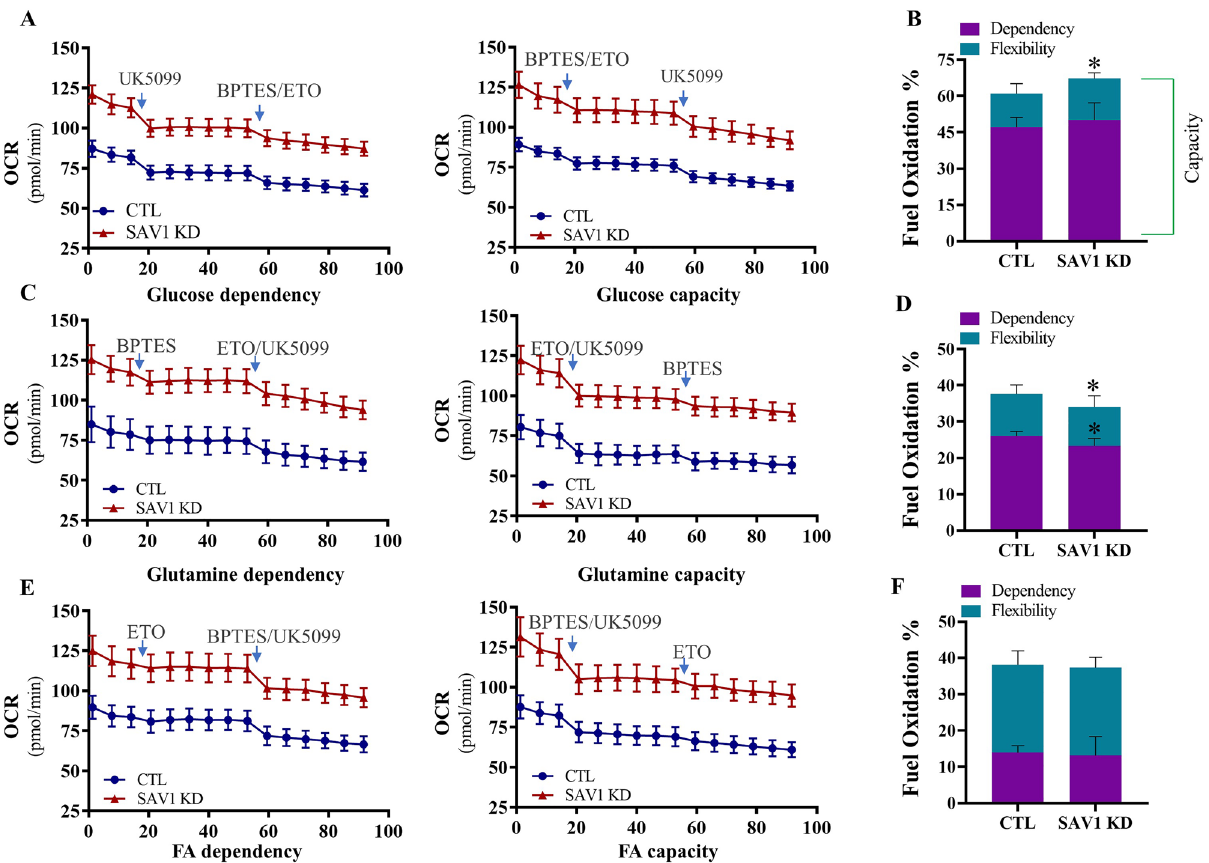
Figure 7. Distinct effects of SAV1 KD cells on mitochondrial flexibility for using fuel. ( A ) Representative traces of measurements of oxygen consumption rate (OCR) showing the dependency on and capacity for glucose oxidation after injection of inhibitors (individually or in combination) as indicated in the graph. UK5099: inhibits glucose oxidation; etomoxir (ETO): inhibits fatty acid oxidation (FAO); BPTES: inhibits glutamine oxidations. ( B ) SAV1 KD cells had significantly enhanced mitochondrial capacity to use glucose oxidation to compensate for inhibition of glutamine oxidation and FAO. Flexibility is the difference between capacity and dependency. *p < 0.05. ( C ) Representative traces of OCR measurements showing the dependency on and capacity for glutamine oxidation after injection of inhibitors (individually or in combination) as indicated in the graph. ( D ) SAV1 KD cells had a significantly lower dependency on and capacity in glutamine oxidation than CTL cells to compensate for the inhibition of glucose oxidation and FAO. *p < 0.05. ( E ) Representative traces of OCR measurements showing the dependency on and capacity for FAO after injection of inhibitors (individually or in combination) as indicated in the graph. ( F ) SAV1 KD and CTL cells had similar flexibility in FAO when both glucose and glutamine oxidation pathways were blocked. Unpaired t test; Data are mean ± SD, n = 4 independent reserve to meet energy-demanding situations. In contrast, SAV1 KD cells exhibited a higher glycolytic capacity to maximize glucose breakdown to produce more ATP via glycolysis. These efficient shifts in metabolism to adapt